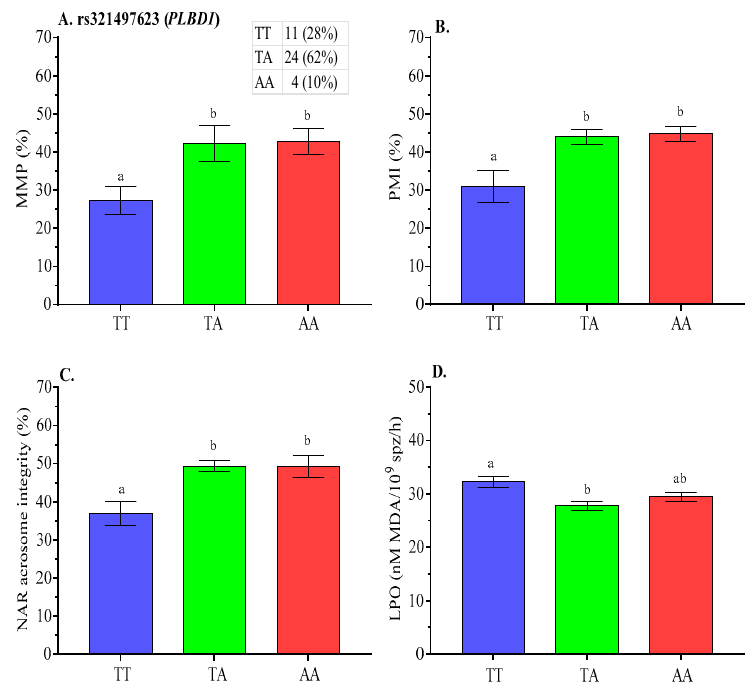
Figure 4. Effect of PLBD1 gene polymorphism on post ‐ thaw A . MMP, B . PMI, C . NAR acrosome integrity, and D . LPO of boar spermatozoa. Data are presented as the mean ± SEM. a,b Differences between genotypes were significantly differed at p < 0.05.